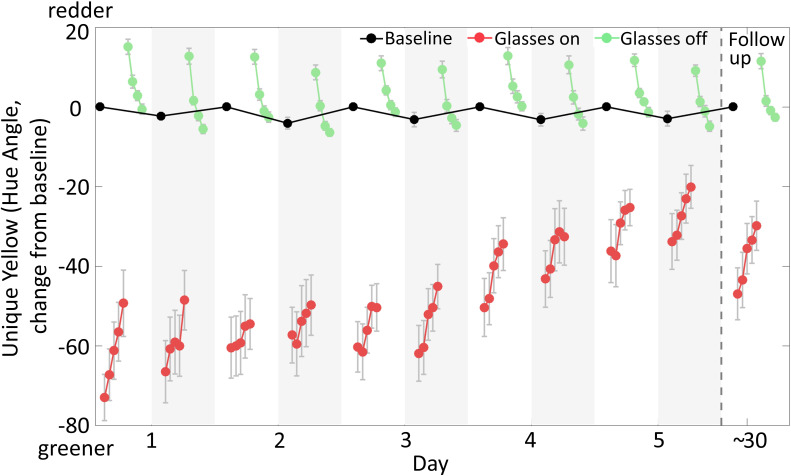
Baseline-corrected results of the main experiment and the follow-up session.Mean unique yellow settings represented in hue angle are plotted as a function of time for 5 days and the follow-up test. Data were normalized by subtracting the baseline value for each morning test session, taken immediately before putting the glasses on in the morning. The black dots are baseline settings, made at the beginning of each test session with glasses off. The white background indicates morning sessions, and the light gray background indicates afternoon. The red dots plot settings with glasses on and the green dots are settings after removing the glasses. Successive symbols are plotted for each 5-min test. The gray bars represent standard errors of the mean, computed across participants (N = 11). These baseline-corrected results showed an identical overall pattern across days as the uncorrected data, though some effects became slightly larger.